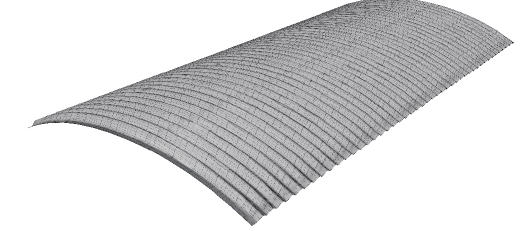
Figure 9 . NURBS model of the Hall B vault, modelled following an as-built strategy.